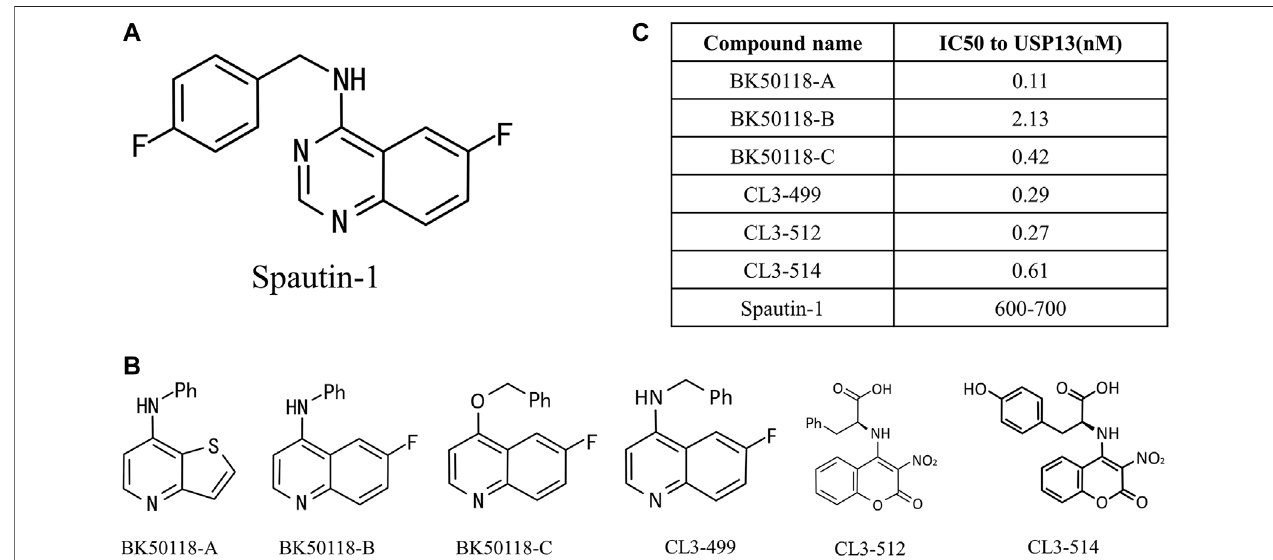
FIGURE 4 | USP13 inhibitors. (A) Chemical structure of Spautin-1; (B) Spautin-1 derivatives; (C) IC50 to USP13 was calculated.